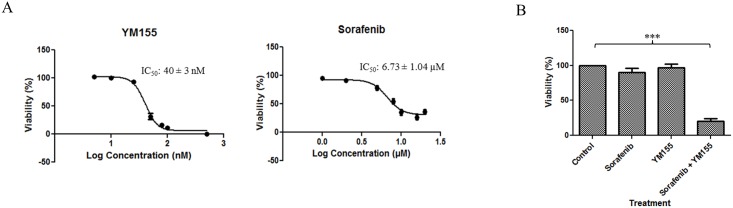
Growth inhibitory activity of YM155 and sorafenib alone and in combination.In MTS cell proliferative assay, (A) the IC50 of YM155 was 40 ± 3 nM. Sorafenib had an IC50 of 6.73 ± 1.04 μM but the growth inhibitory effect does not go below 64%. (B) Drugs in combination at ½ x IC50 reduced cell viability to ~20% as compared to the negligible effects elicited by either drug used alone at the same concentration. *** p < 0.001 compared to control.